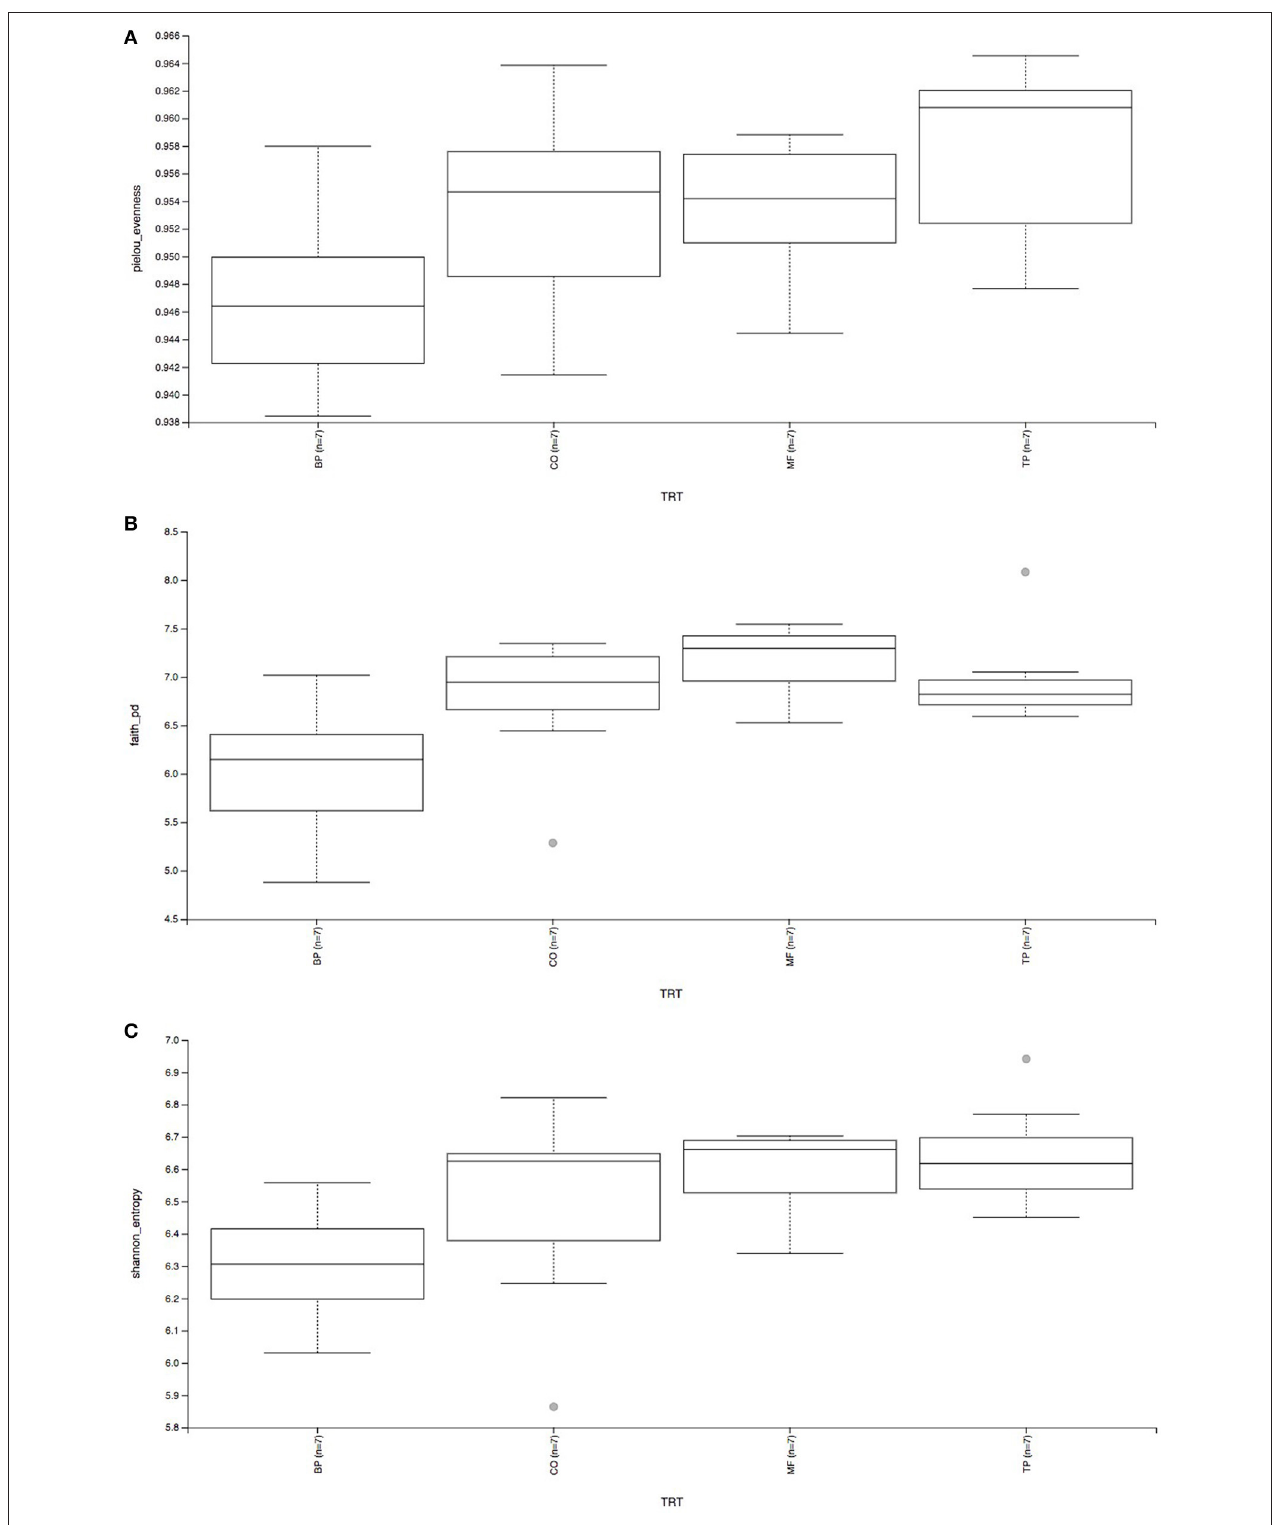
FIGURE 3 | Alpha-diversity analysis of fecal microbial communities, measured by Pielou evenness (A) , Faith’s phylogenetic diversity (B) , and Shannon entropy (C) of cats fed diets containing traditional and novel fiber sources.